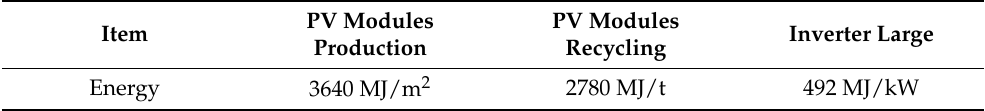
Table 3. Energy factors. Adapted from [12].